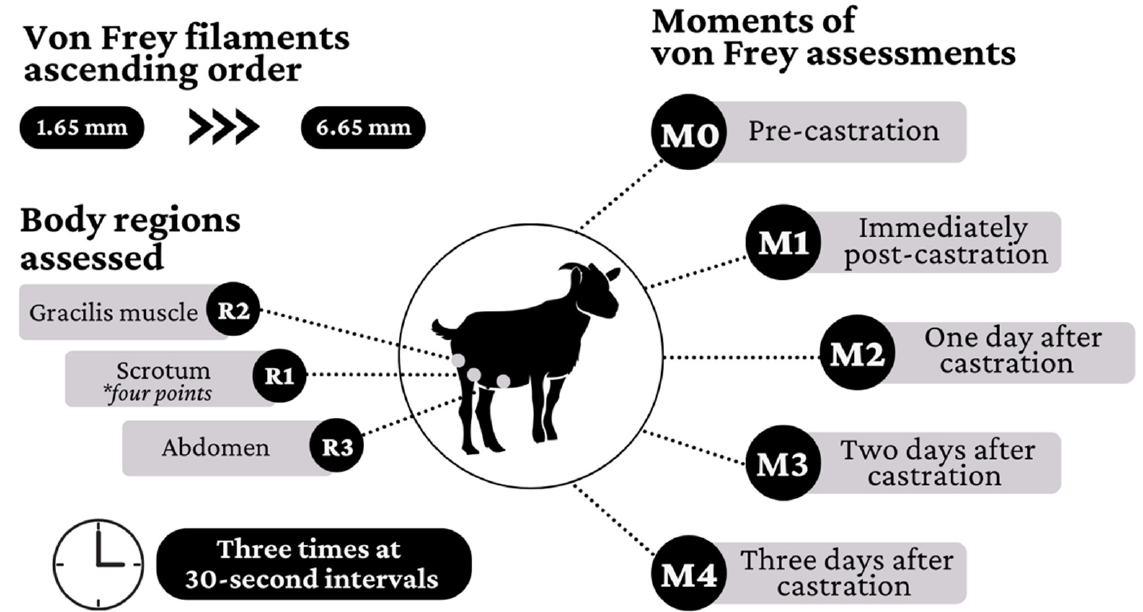
Figure 1. Body regions assessed (R1 = at four points of the scrotum (dorsal and ventral; left and right lateral); R2 = medial region of the pelvic limb (gracilis muscle); and R3 = hypogastric region of the abdomen.) and moments of von Frey filament test assessments (M0 = pre-castration, M1 = immediately post-castration, M2, M3 and M4 = 1, 2, and 3 days after castration, M4, respectively).